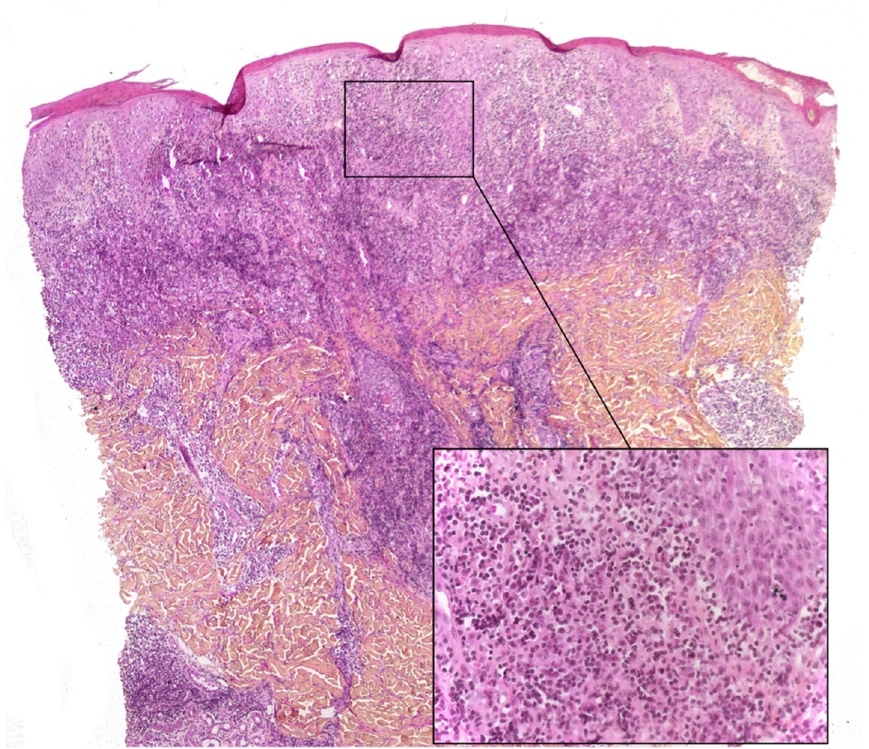
Figure 4. Lymphoplasmacytic plaque: parakeratotic scale, epidermal hyperplasia, a dense lymphoplasmacytic infiltrate in the whole dermis. Inset: note the numerous plasma cells. HE ×40 (inset: ×200).